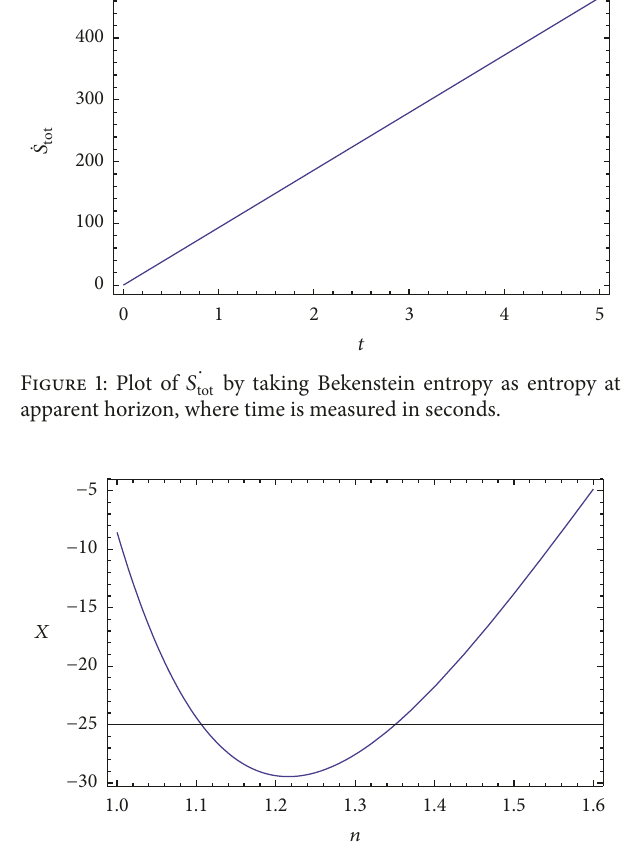
Figure 2: Plot of 𝑋 = at apparent horizon.